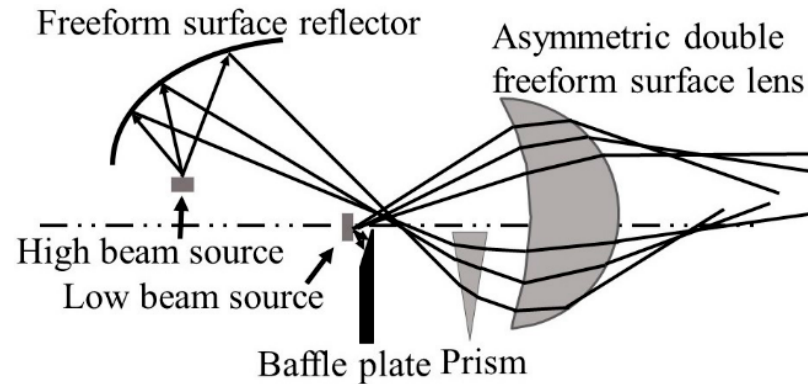
Figure 1. Optical system of the integrated LED automobile headlamp.